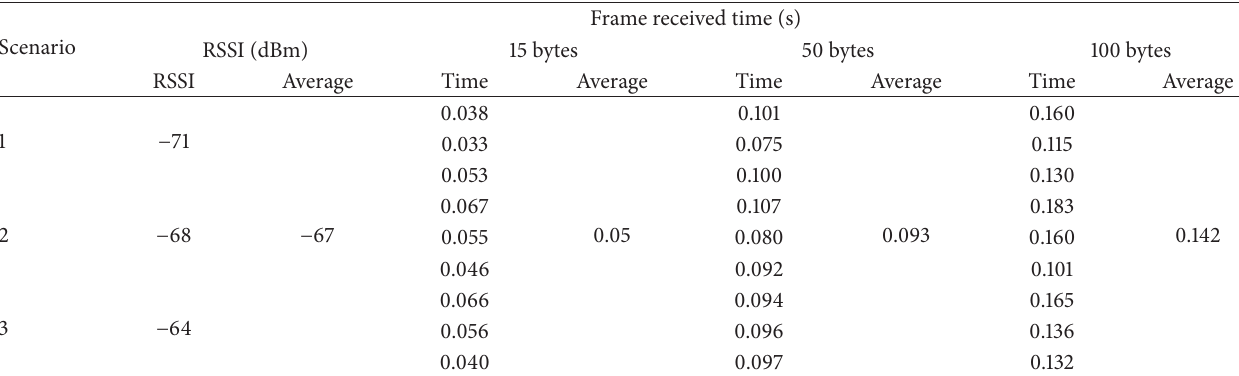
Table 2: Experimental results of Case 1 .